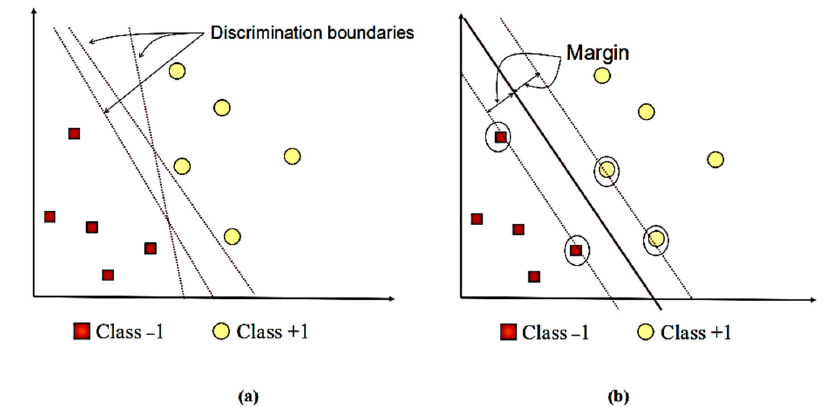
Fig. 1. HyperPlane